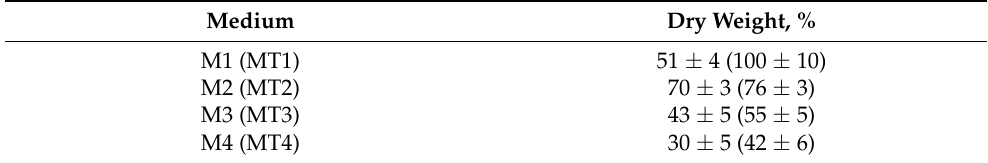
Table 2. Trichoderma asperellum dry weight (%) from the bioreactor experiment. One hundred percent—highest biomass reached in experiment. The percentage of other biomasses was adjusted respectively to the highest value.